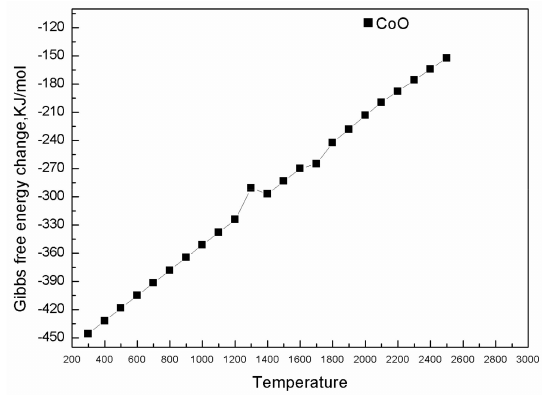
Figure 17. Gibbs free energy of the reaction at di ff erent